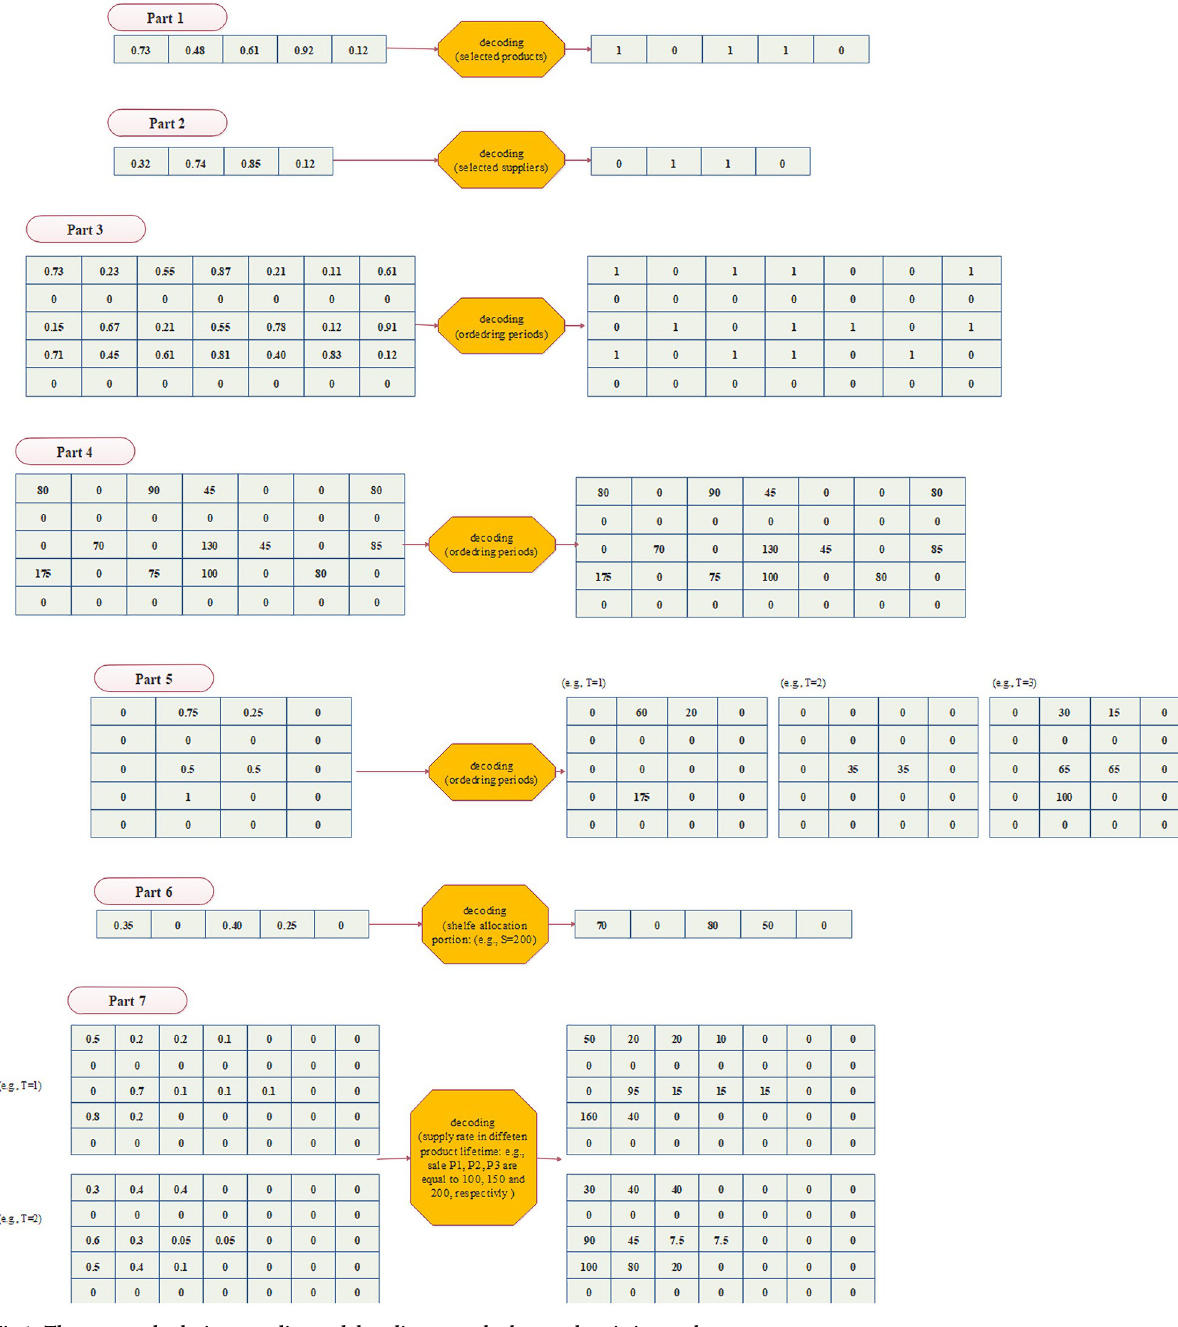
Fig 1. The proposed solution encoding and decoding to apply the metaheuristic